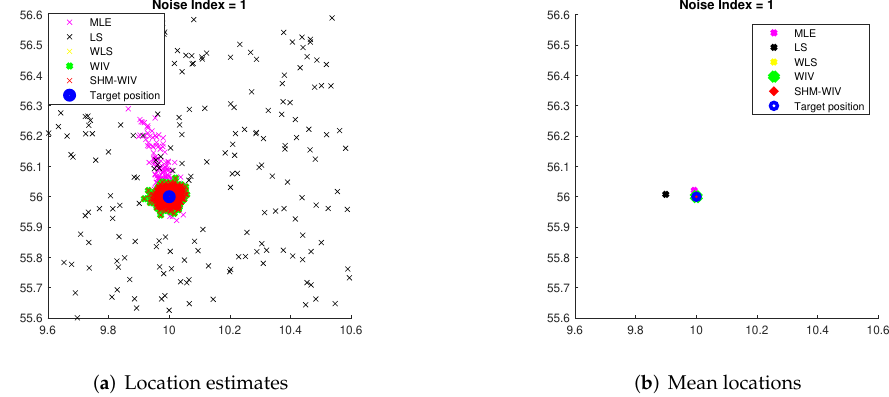
Figure 6. ( a ) Plot of individual location estimates for noise index 1; ( b ) Plot of mean location estimates for noise index 1.